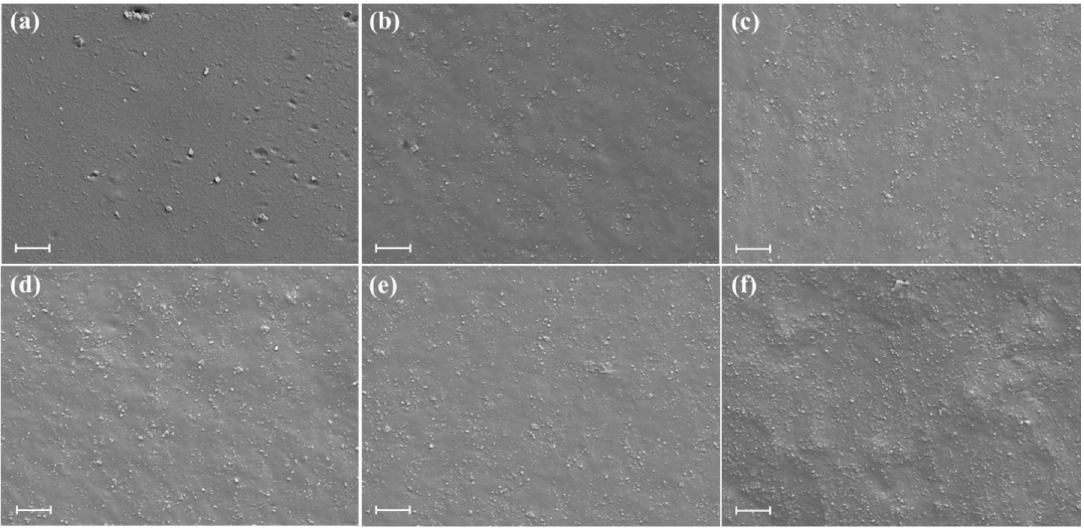
Figure 3 . SEM images of SBR composites: ( a ) neat SBR, ( b ) SBR/ST-10, ( c ) SBR/ST-20, ( d ) SBR/ST-30, Figure 3. SEM images of SBR composites: ( a ) neat SBR, ( b ) SBR / ST-10, ( c ) SBR / ST-20, ( d ) SBR / ST-30, ( e ) SBR/ST-40, and ( f ) SBR/ST-50, the scale bar is 2 µm. ( e ) SBR / ST-40, and ( f ) SBR / ST-50, the scale bar is 2 µ